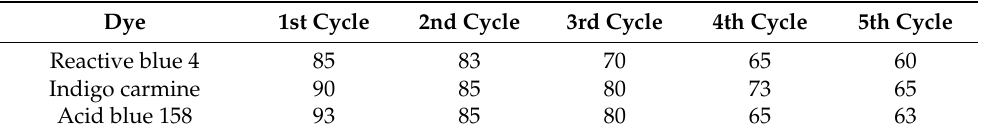
Table 2. Efficacy of the adsorbent after cycles of adsorption–desorption.